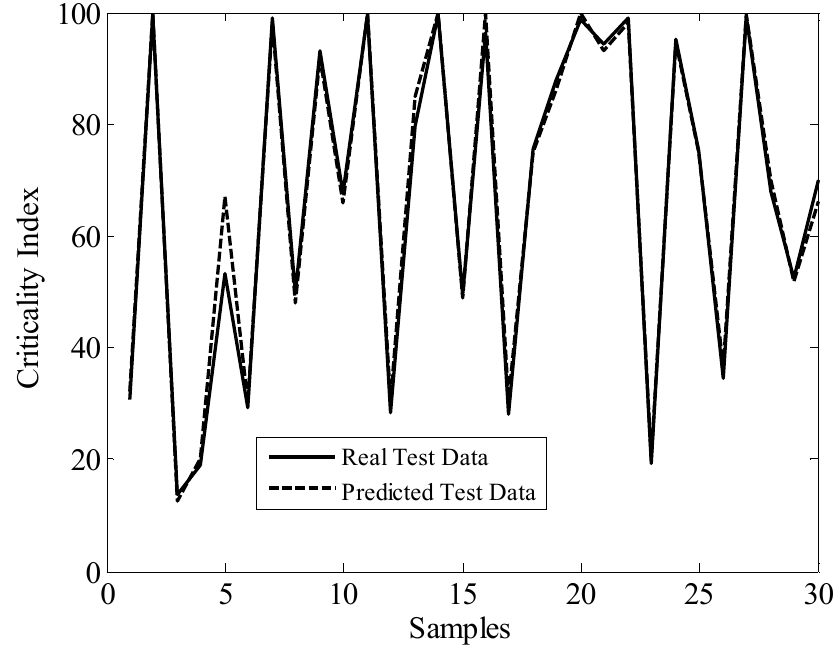
Figure 12. ANN testing.